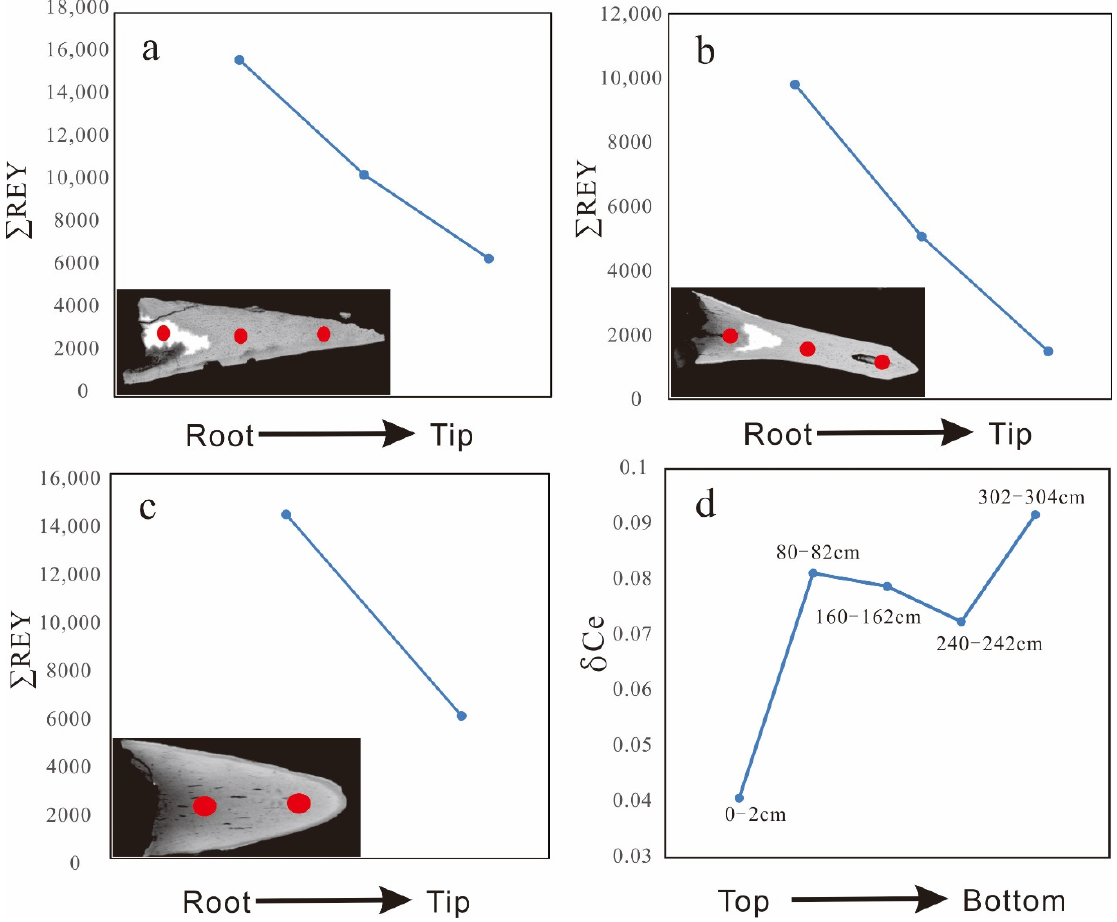
Figure 8. In situ compositional analyses showing the REY and δ Ce gradients in the bioapatites. ( a – c ) The contents gradients of REY in the bioapatite fossils. ( d ) δ Ce gradients in the bioapatite fossils in different depths.